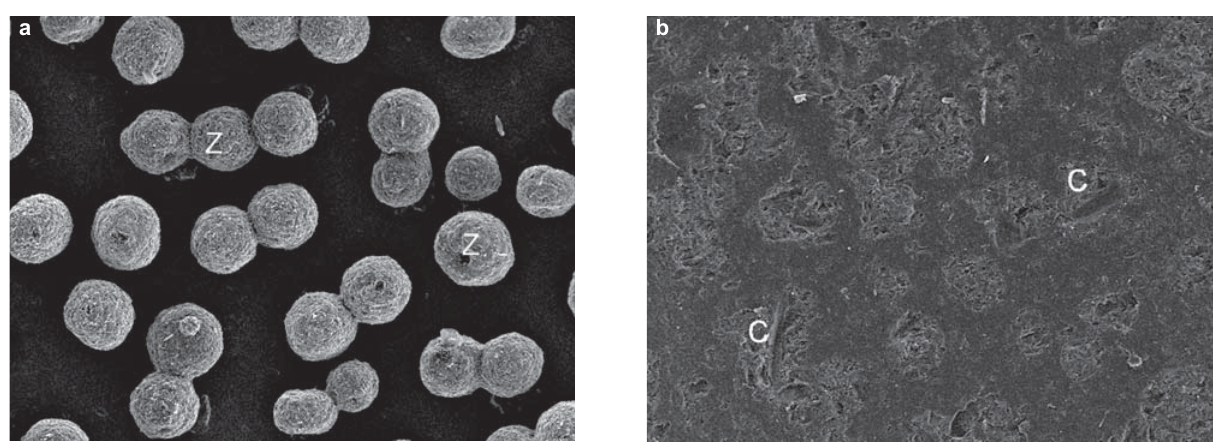
Figure 1- (cid:10)(cid:27)(cid:17)(cid:28)!!(cid:21)!$(cid:10)(cid:23)(cid:31)(cid:23)(cid:17)(cid:22)(cid:30)(cid:15)!(cid:10)(cid:18)(cid:21)(cid:17)(cid:30)(cid:15)(cid:20)(cid:17)(cid:15)(cid:19)#(cid:10)(cid:21)(cid:18)(cid:28)$(cid:23)(cid:20)(cid:10)(cid:21)!(cid:10)(cid:27)>(cid:10)(cid:18)(cid:15)"(cid:23)(cid:10)(cid:29)(cid:20)(cid:21)!$(cid:10)(cid:11)(cid:12)(cid:3)(cid:3)(cid:3)?(cid:10)(cid:18)(cid:28)$!(cid:21)&(cid:17)(cid:28)(cid:22)(cid:21)(cid:15)!(cid:10)(cid:20)E(cid:15)H(cid:21)!$K(cid:10)(cid:28)(cid:6)(cid:10)W(cid:28)(cid:20)(cid:23)(cid:10)(cid:15)(cid:16)(cid:10)!(cid:23)H(cid:10)W(cid:30)(cid:28)(cid:17)<(cid:23)(cid:22)(cid:10) with zirconia pearls (Z) as a mechanical retention mechanism spread on the alumina surface; b) base of bracket following tribochemical silica coating. Note the absence of zirconia pearls. Instead, the alumina surface presented cracks on the spots where the zirconia pearls were sputtered (C)